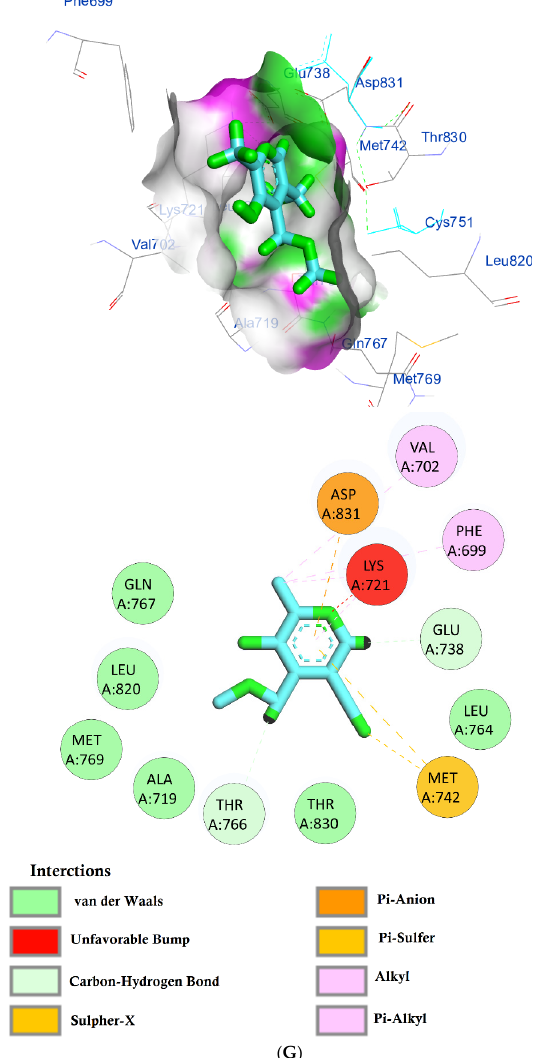
Figure 6. ( A ) Protein-ligand interactions of identified bioactive metabolites of P. tomentosa L. latex with the active site of EGFRK. Diagrams representing 3D and 2D protein–ligand interactions of ouabagenin with the active site of EGFRK. ( B ) Protein–ligand interactions of identified bioactive metabolites of P. tomentosa L. latex with the active site of EGFRK. Diagrams representing 3D and 2D protein–ligand interactions of corchoroside A. with the active site of EGFRK. ( C ) Protein–ligand interactions of identified bioactive metabolites of P. tomentosa L. latex with the active site of EGFRK. Diagrams representing 3D and 2D protein–ligand interactions of xanthyletine with the active site of EGFRK. ( D ) Protein–ligand interactions of identified bioactive metabolites of P. tomentosa L. latex with the active site of EGFRK. Diagrams representing 3D and 2D protein–ligand interactions of prenyl arabinosyl-(1->6)-glucoside with the active site of EGFRK. ( E ) Protein–ligand interactions of identified bioactive metabolites of P. tomentosa L. latex with the active site of EGFRK. Diagrams repre- senting 3D and 2D protein–ligand interactions of furaneol 4-glucoside with the active site of EGFRK. ( F ) Proteinx–ligand interactions of identified bioactive metabolites of P. tomentosa L. latex with the active site of EGFRK. Diagrams representing 3D and 2D protein–ligand interactions of methyl orselli- nate with the active site of EGFRK. ( G ) Protein–ligand interactions of identified bioactive metabolites of P. tomentosa L. latex with the active site of EGFRK. Diagrams representing 3D and 2D protein–ligand interactions of ginkgotoxin with the active site of